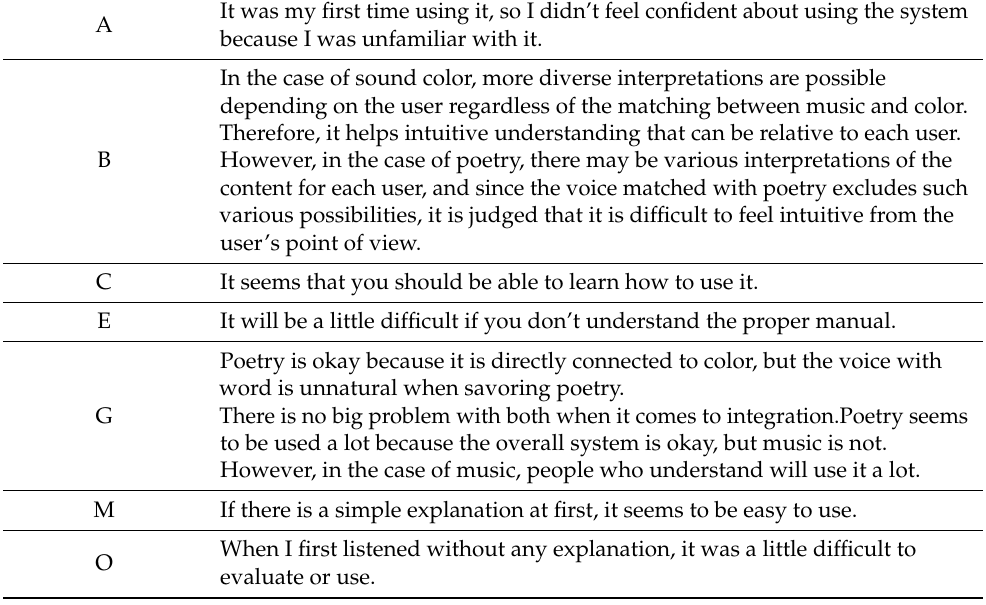
Table 11. Negative user feedback from the System Usability Scale test.